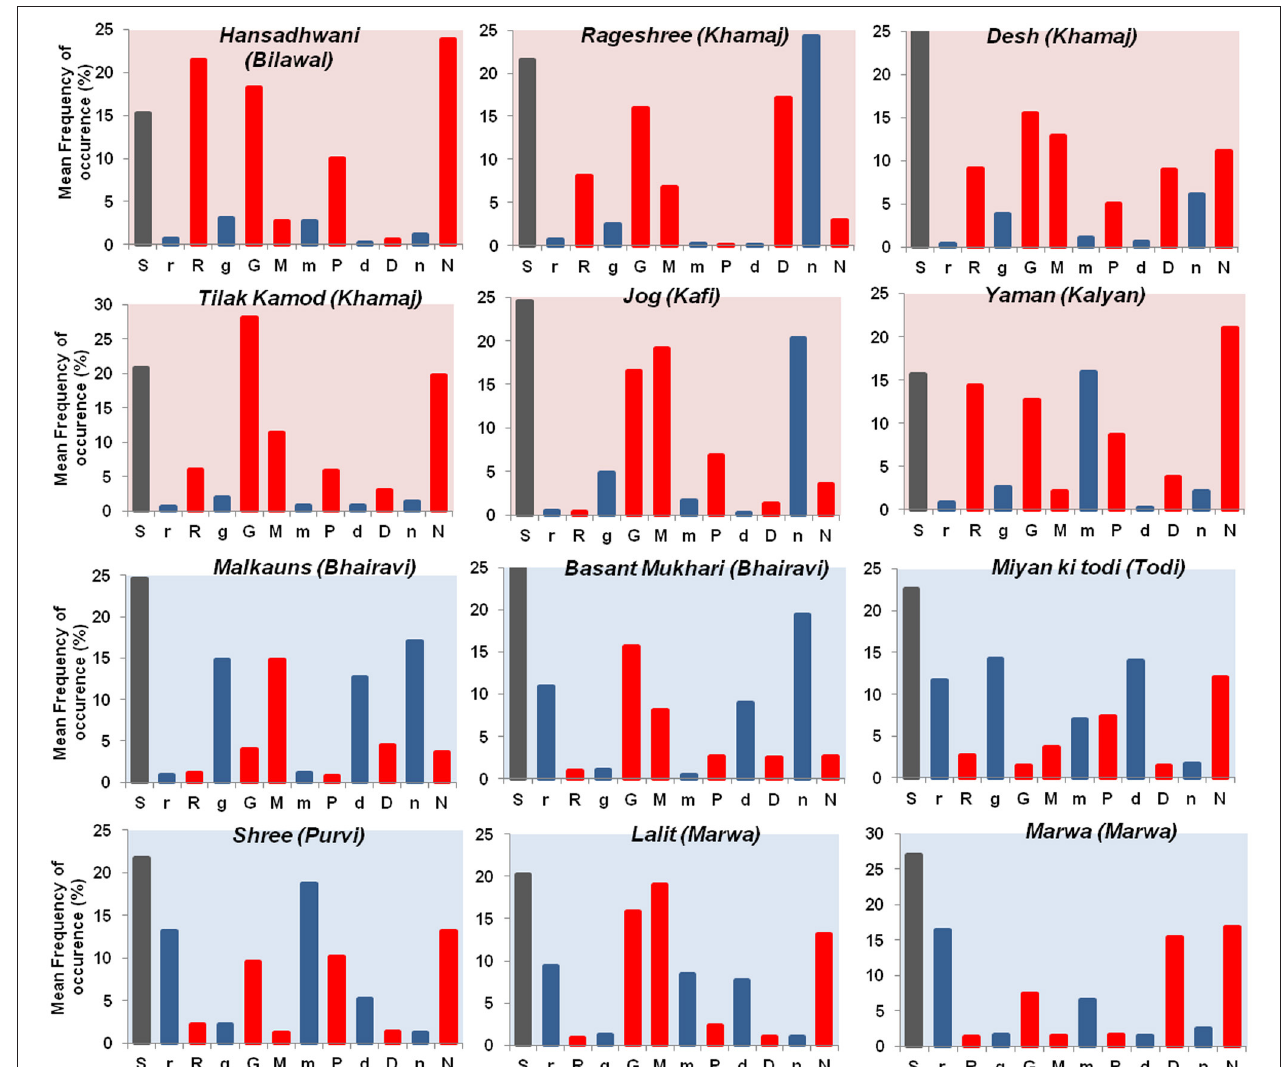
FIGURE 2 | Tonality for ragas . The above figure represents the tonic interval distribution for the 12 ragas used in the study (Mathur et al., 2015). The tonal distribution of ragas rated as “calm” is represented with red background color panel whereas the tonal distribution of ragas rated as “sad” is represented with blue background color panel. Within each panel the mean frequency of occurrence of shuddh swaras [S ( Sa ), R ( Re ), G ( Ga ), M ( Ma ), P ( Pa ), D ( Dha ), N ( Ni )] is depicted with red bars whereas the mean frequency of occurrence of komal swaras [r( re ), g( ga ), m( ma ), d( dha ), n( ni )] is depicted with blue bars.